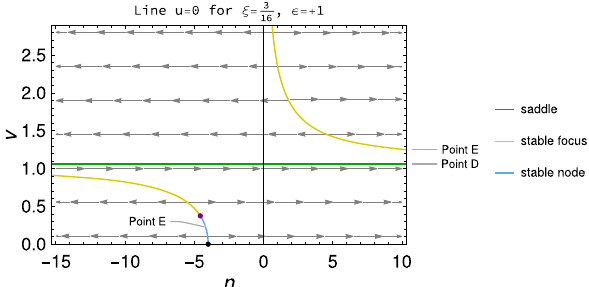
Fig. 7 Bifurcation diagram of the local stability of equilibrium points of system (25) on the u = 0 line under variation of the parameter n for fixed ξ = 3 and ε = + 1. The black dot in this diagram denotes a 16 non-hyperbolic equilibrium point, while the purple dot denotes a stable degenerate node. Grey arrows show the direction of the flow on the u = 0 line – arrows directed to the right denote the flow following towards increasing values of u , whereas arrows directed to the left denote the flow following towards decreasing values of u . The flow on the u = 0 line is perpendicular to this line since on it v (cid:7) = 0 in system